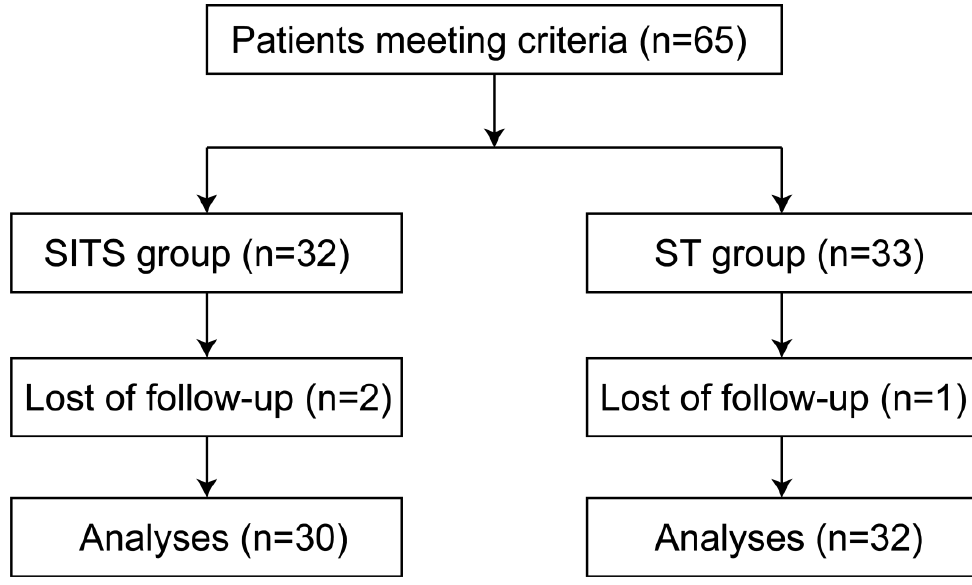
Figure 1. Study workflow.